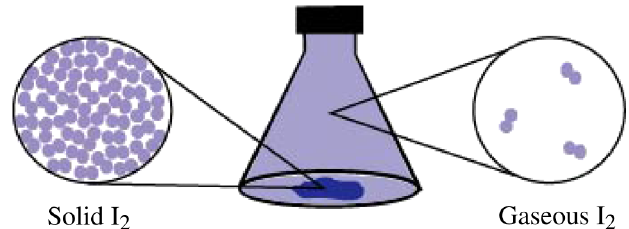
FIG. 5 (color online). Students are asked to draw particulate- level representations of solid and gaseous I 2 (iodine). One potentially correct answer is